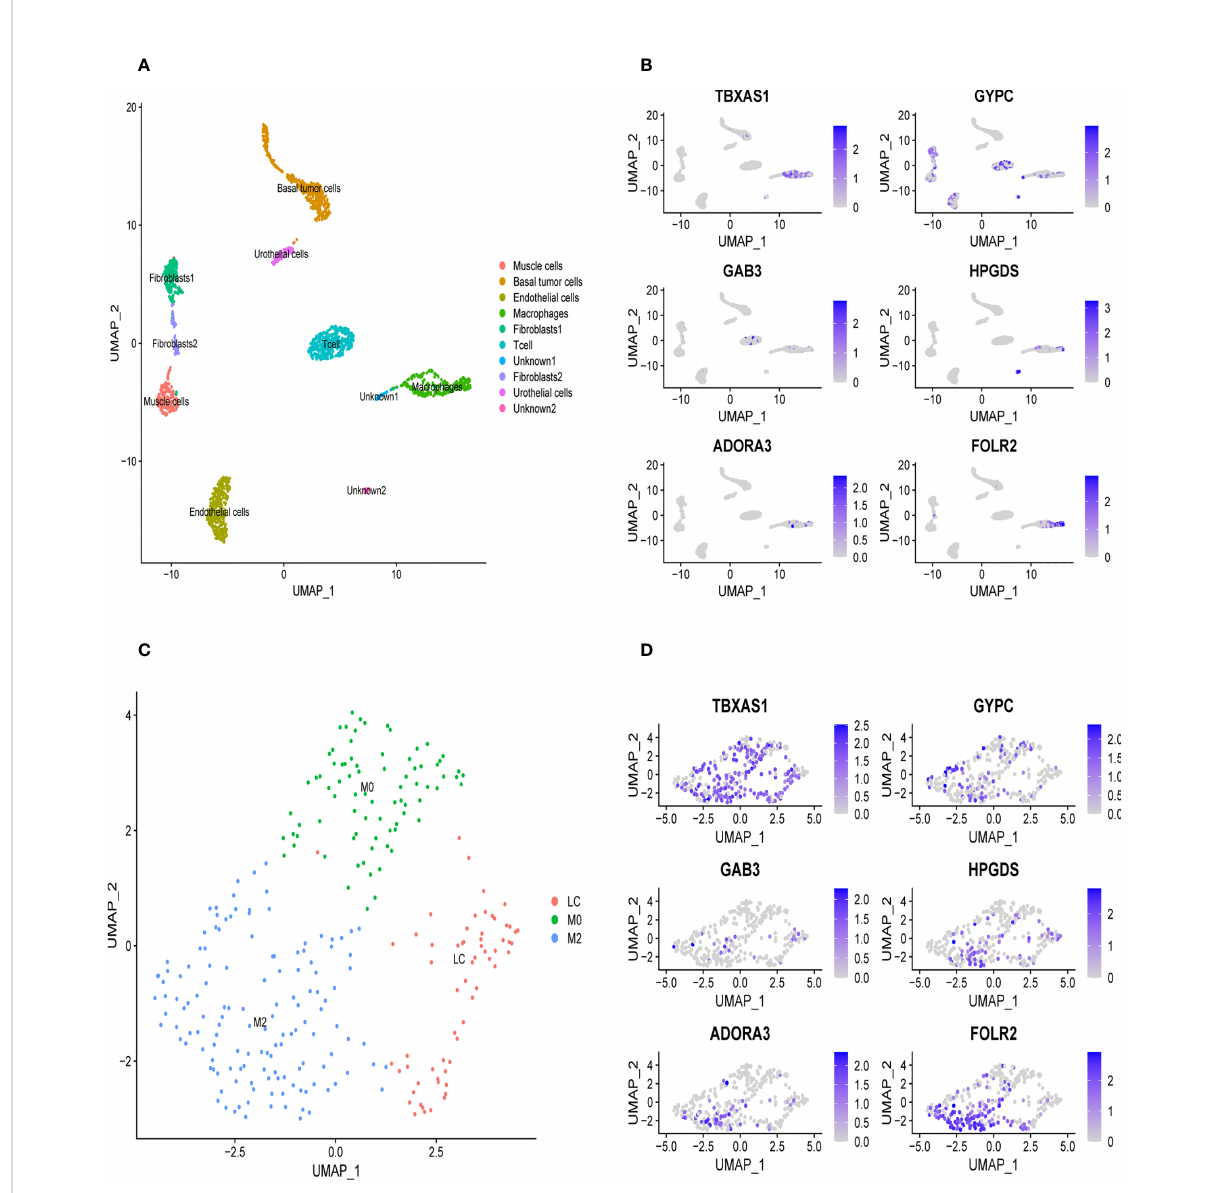
FIGURE 7 Validation of the speci fi c expression level of six genes in single cell sequence data based on GSE145137 (A) Umap plots of single cell sequence data in GSE145137 (B) The expression level of six genes in macrophages. (C) Macrophage is subdivided into three clusters. (D) The expression level of six genes in M2